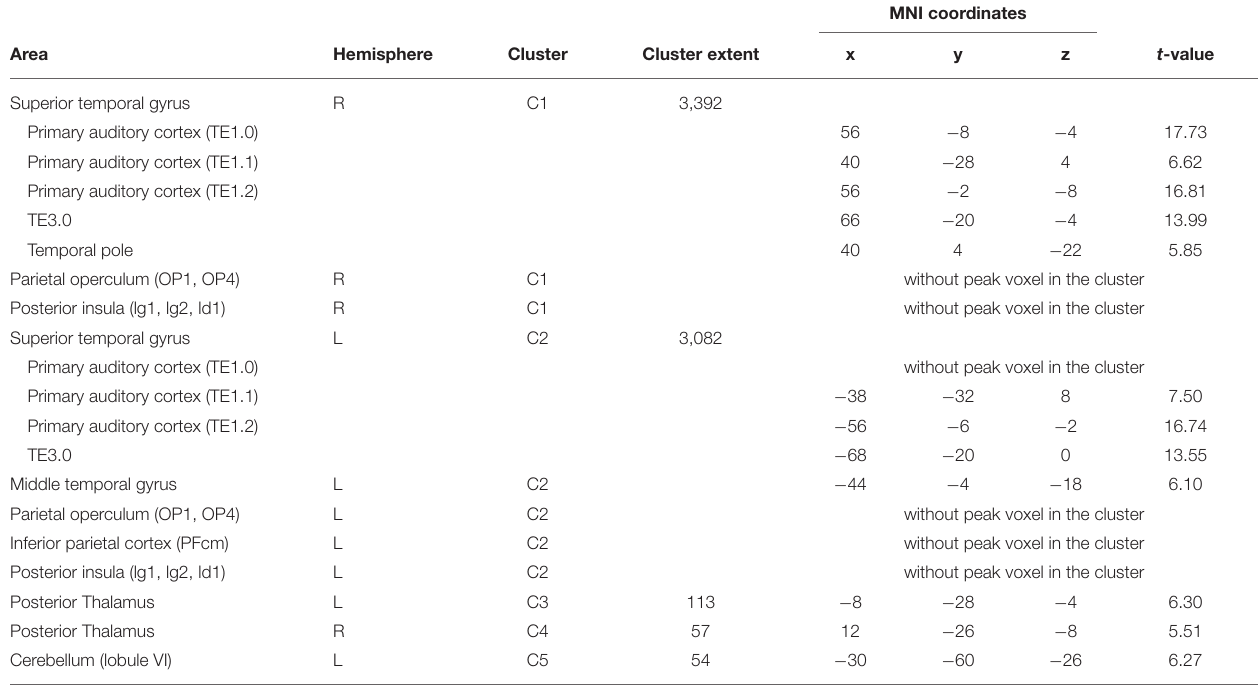
TABLE 2 | Activations during positive > neutral auditory stimulation (A + > A 0